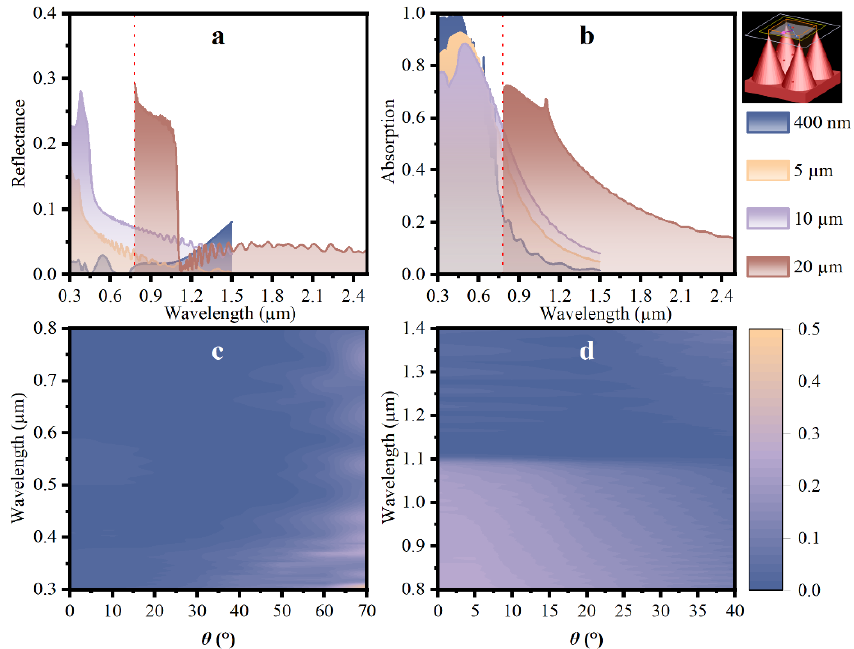
Figure 5. ( a ) Reflectance spectra and ( b ) absorptance spectra for structures with different heights (400 nm, 5 µm, 10 µm, 20 µm); reflectivity for structures with heights of ( c ) 400 nm and ( d ) 20 µm under varying incident angles as a function of wavelength.